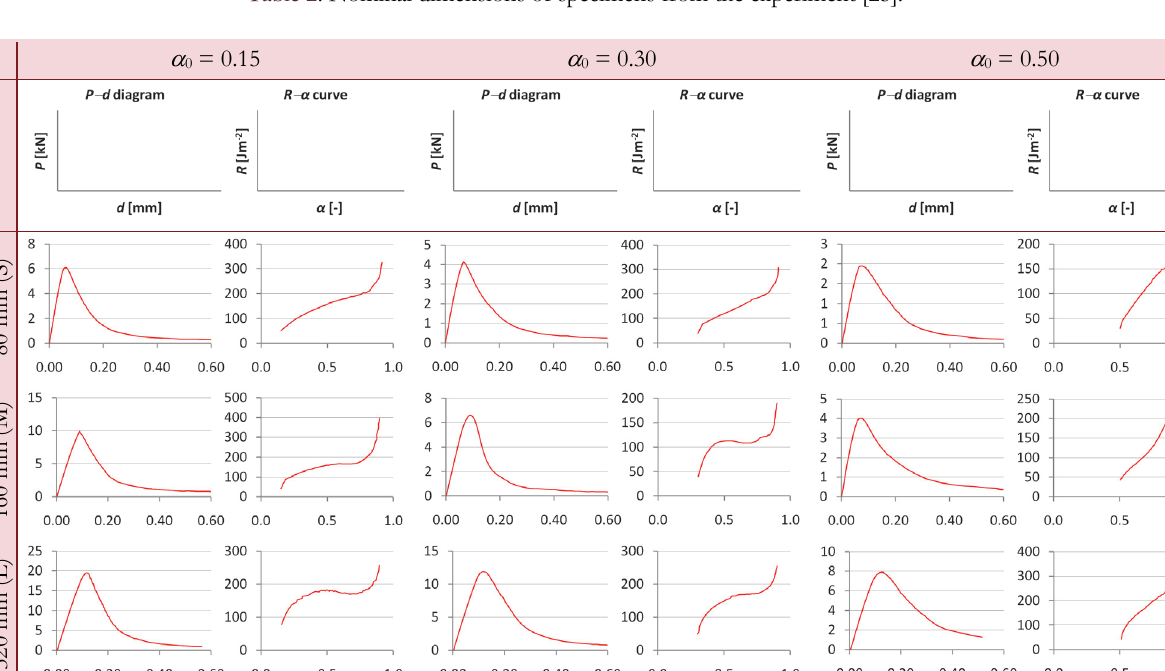
Table 2: Nominal dimensions of specimens from the experiment [25].